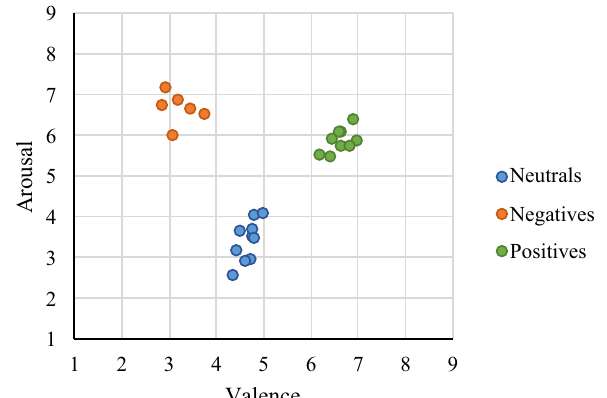
Figure 2. Average valence and arousal scores per video visualized on the 2-Dimensional affective space.